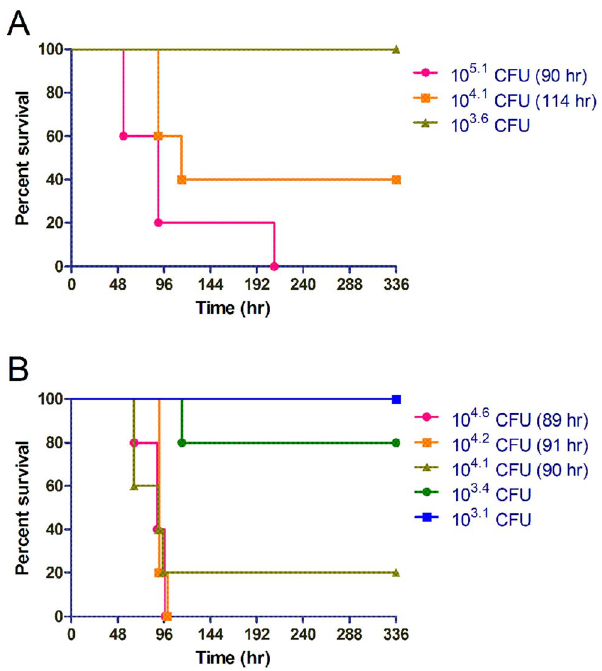
Fig. 2. Host response to lung-specific delivery of B. pseudo- mallei . Groups of 5 female albino C57BL/6J mice were challenged with increasing doses of luminescent B. pseudomallei strain JW280 by either the intranasal (A) or IMIT (B) routes of infection. Mice were monitored for 14 days (336 hr) for disease progression and euthanized at the onset of moribund disease presentation. Survival curves are used to present the dose-dependent response of the host to increasing bacterial challenges. The MTTD was calculated for groups with $ 50% mortality, as indicated. doi:10.1371/journal.pntd.0003441.g002 Fig. 1, we found that IMIT delivery of B. pseudomallei facilities significant disease maturation in all monitored tissues, both at the primary site of infection in the lung, as well as in the disseminated infection of the liver and spleen (Fig. 3). Further, we observe a . 3 log CFU difference of bacterial dissemination through the blood, indicating that moribund mice exhibit a greater degree of septicemia in the IMIT model relative to the i.n. model. Consistent with in vivo diagnostic imaging, bacterial tissue burden analysis reveals that B. pseudomallei infections involving promi- nent URT colonization result in host morbidity associated with reduced disease maturation in core body sites, suggesting that the host morbidity of the i.n. model is directly influenced by the bacterial colonization of the nasal cavity.